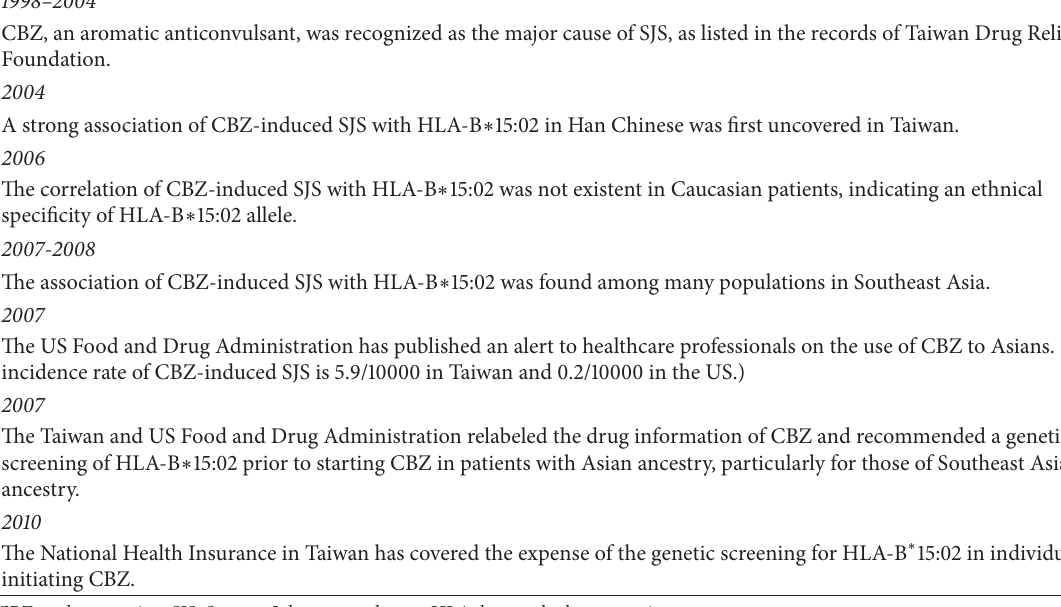
Table 2: Translational roadmap of CBZ-SJS research and its clinical applications